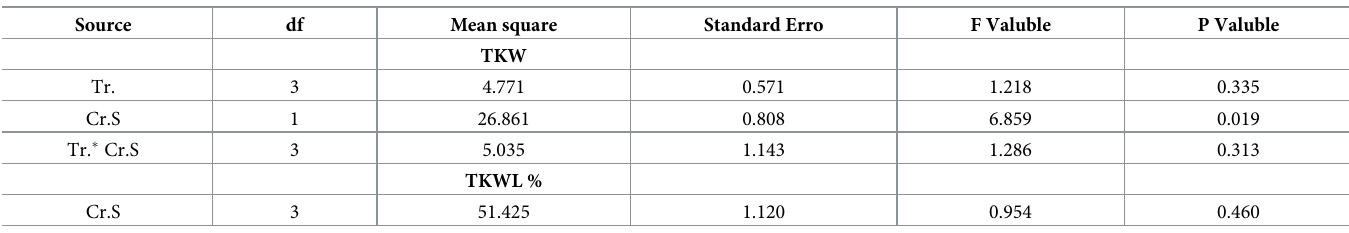
Table 3. The tests of between-subjects effects among different treatments. Source df Mean square Standard Erro F Valuble P Valuble TKW Tr. 3